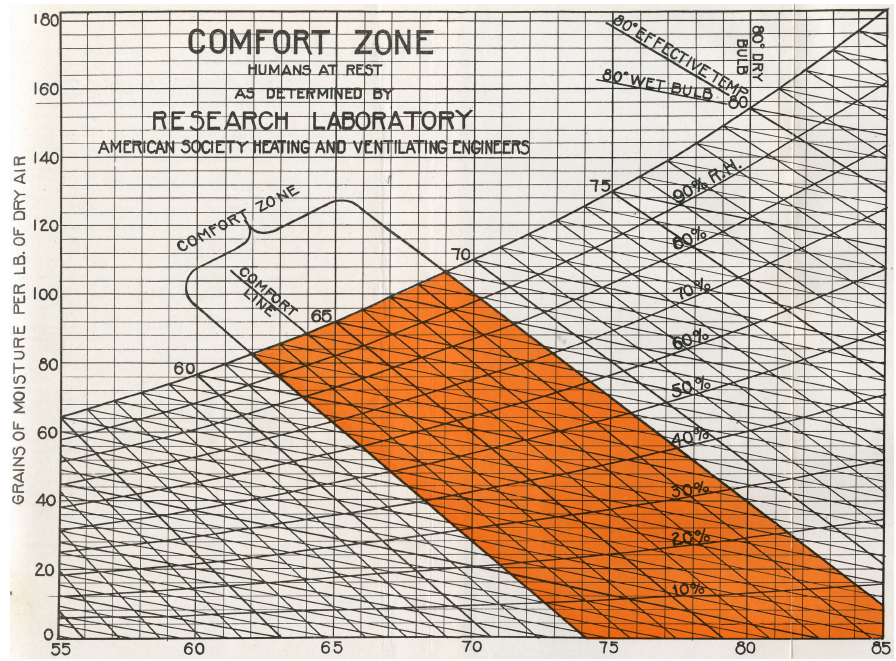
Figure 2. Yagoglou and Houghton’s equal temperature framework [5]. Here, the abscissa is “Dry bulb temperature” and provided in degrees Fahrenheit; the ordinate is “Grains of moisture per lb dry